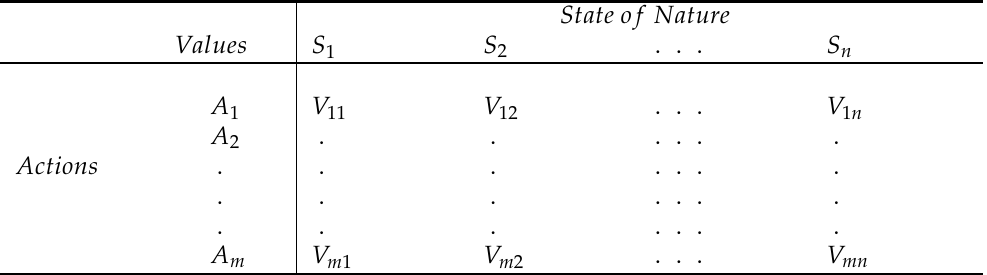
Table 1. Representation of game against nature